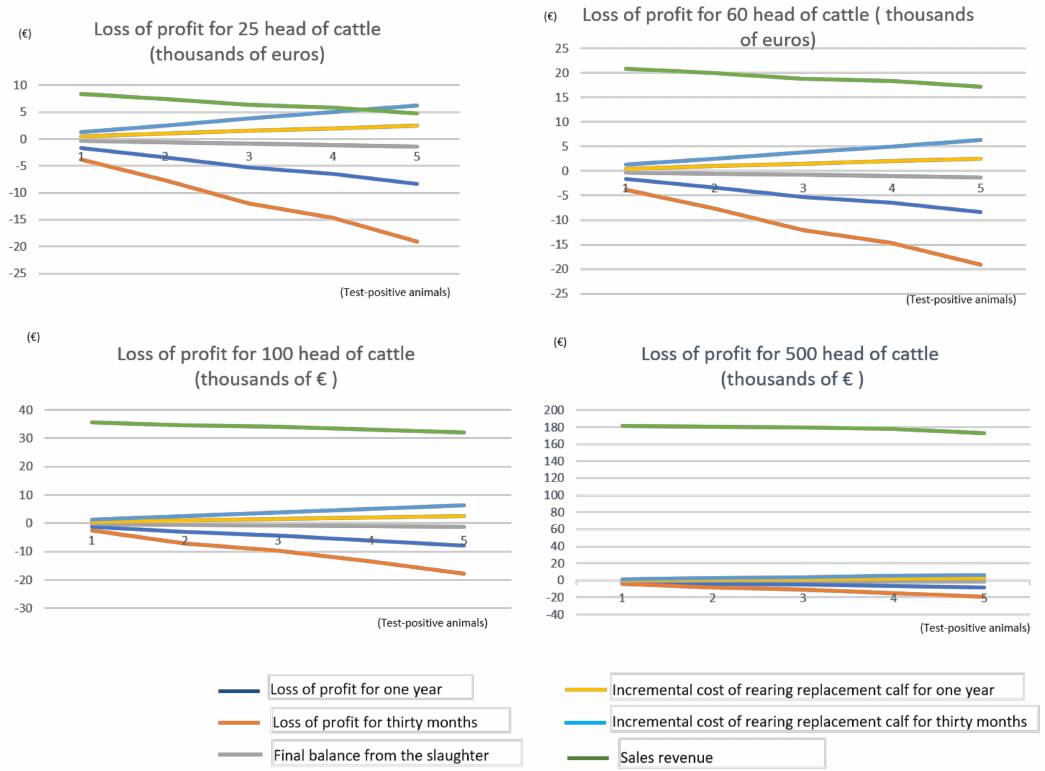
Figure 3. Comparative loss of profit in 25, 60, 100, and 500 head of cattle.